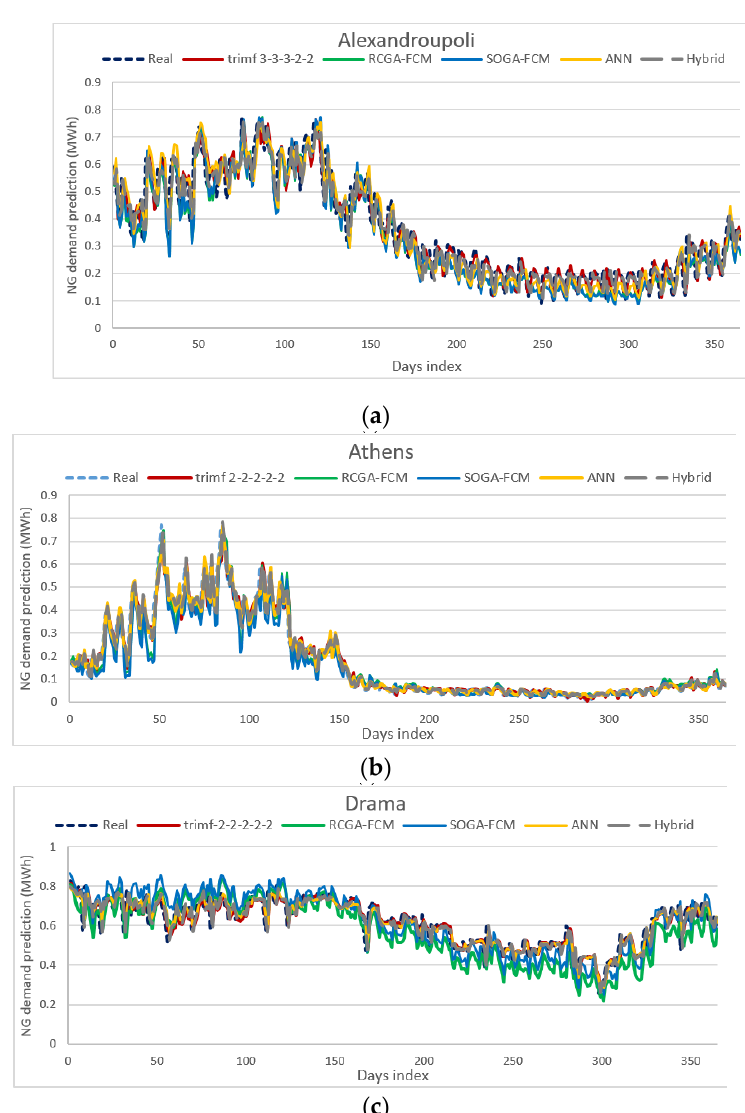
Figure 9. Comparison of forecasting results for each city considering all examined methods. ( a ) Testing for Alexandroupoli, ( b ) Testing for Athens, ( c ) Testing for Drama.